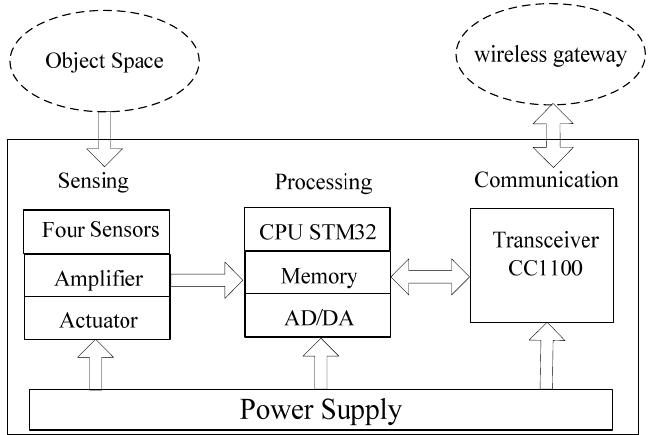
Figure 3 . The composition of pyroelectric infrared (PIR) senor